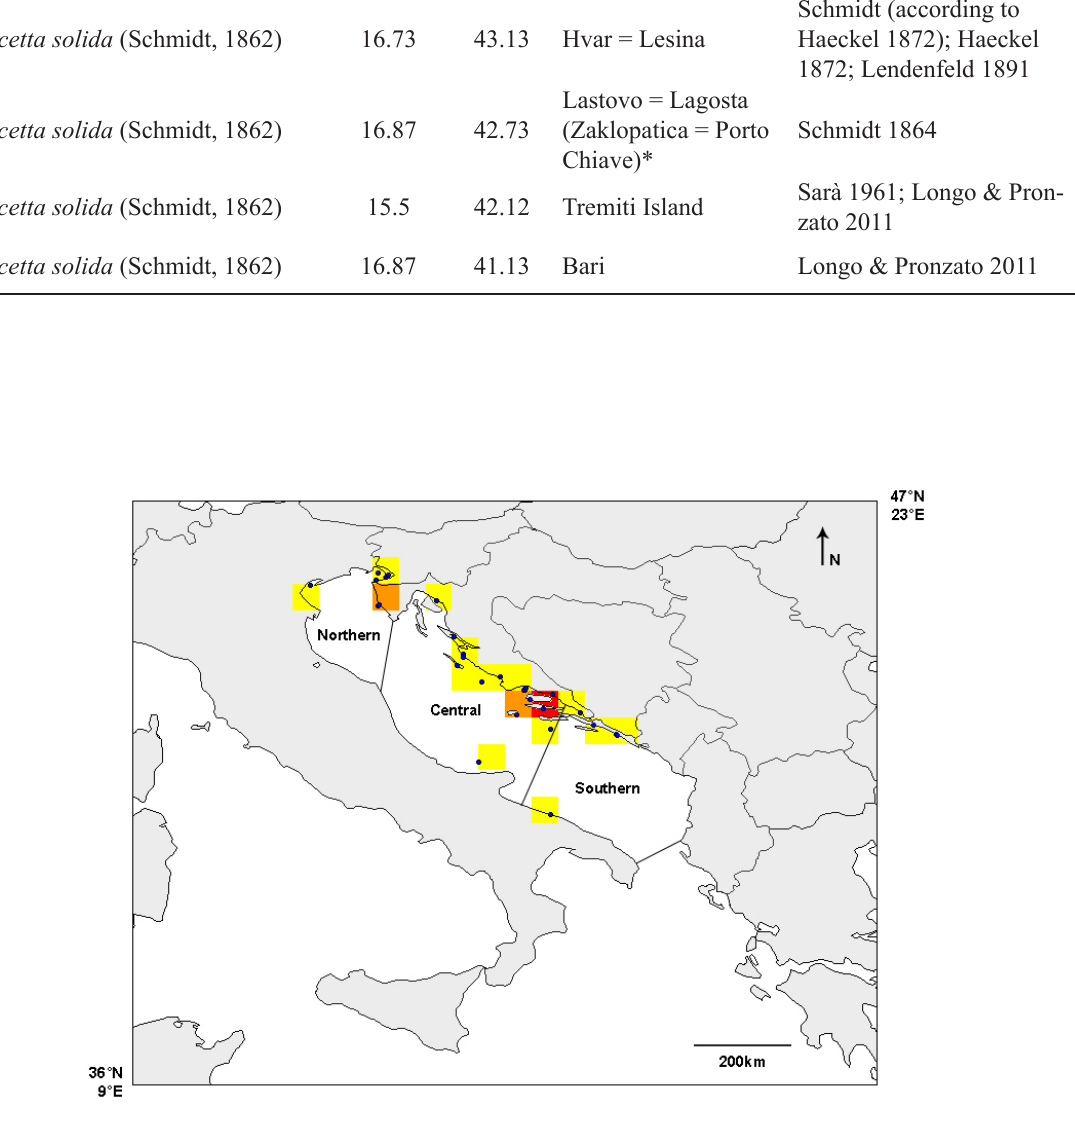
Fig. 20. Species richness in the Adriatic Sea divided by sectors. 18–26